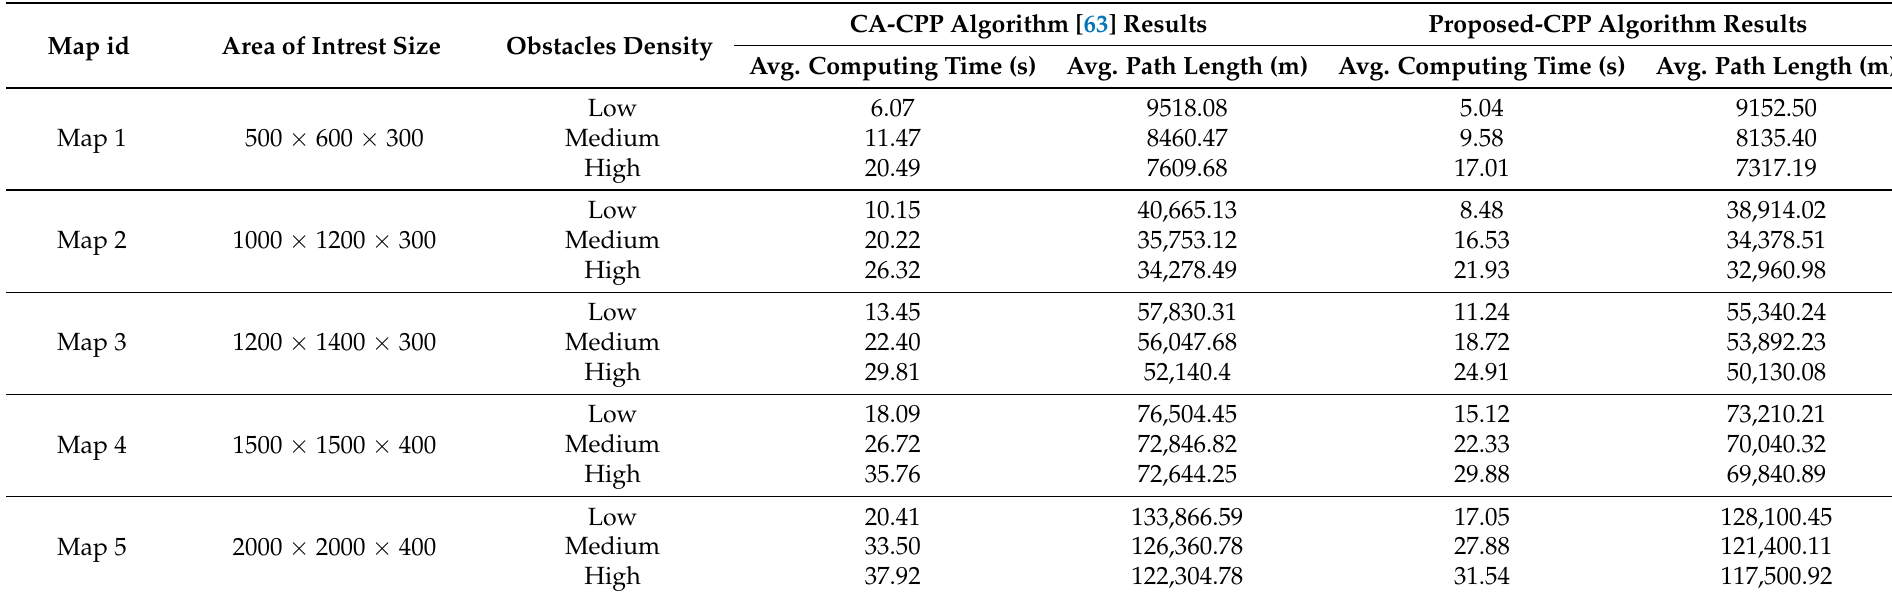
Table 3. Description of the AOI and the proposed algorithm CPP results in comparison with the CA-CPP method.